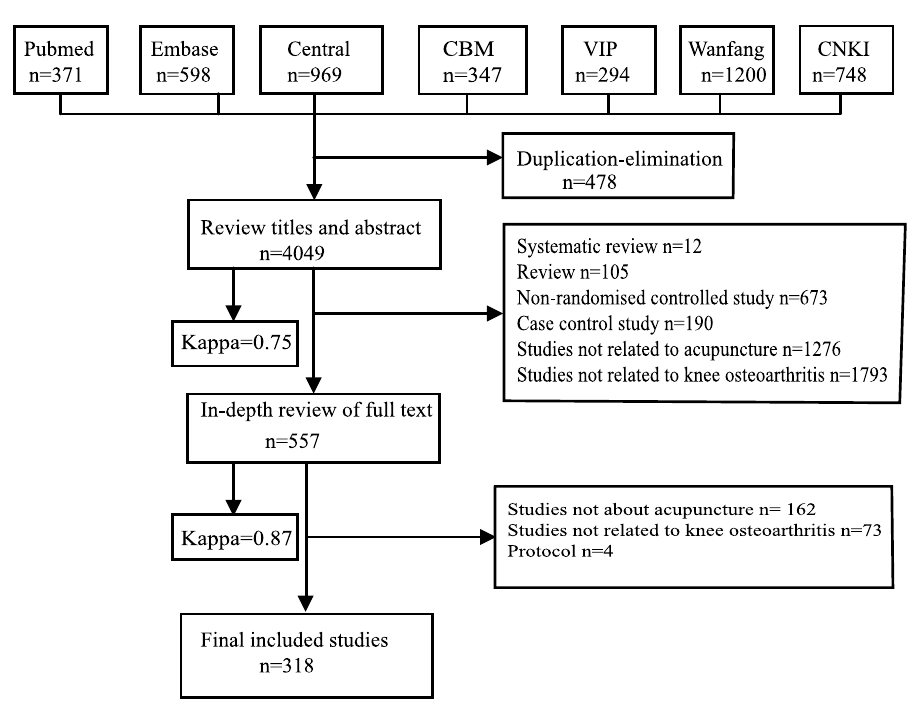
Fig 1. Flow diagram for searching and selection